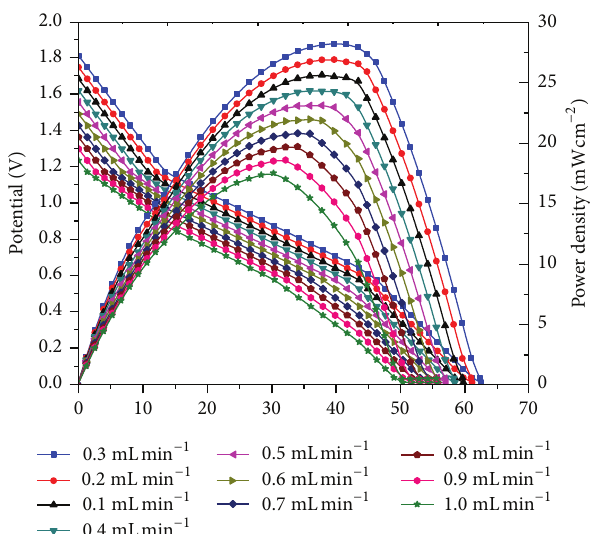
Figure9:Effectofflowrateoffuelmixtureonthecurrentandpower density of the MLSPBFC at room temperature. [Fuel]: 2 M formic